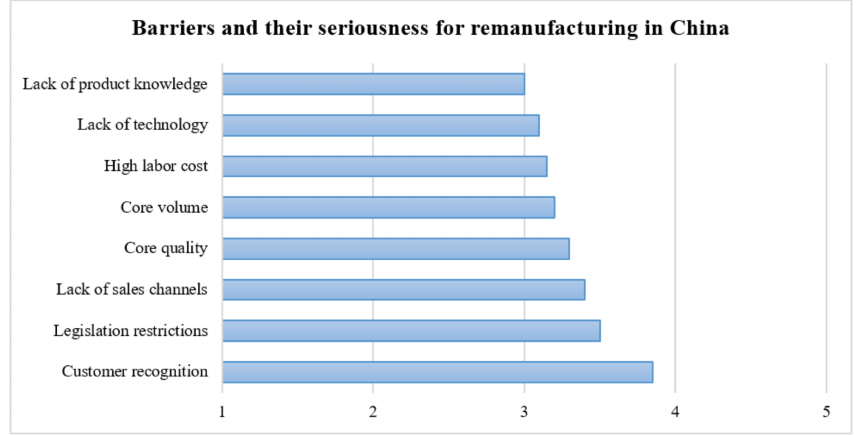
Figure 5. Overall barriers for remanufacturing in China (adapted from [143]).